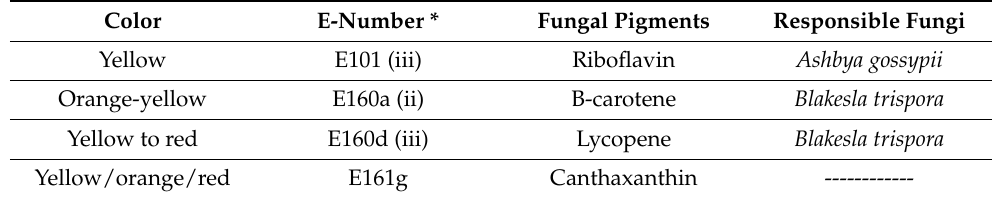
Table 2. Some authorized food-grade fungal pigments available in the current global market [74,190].